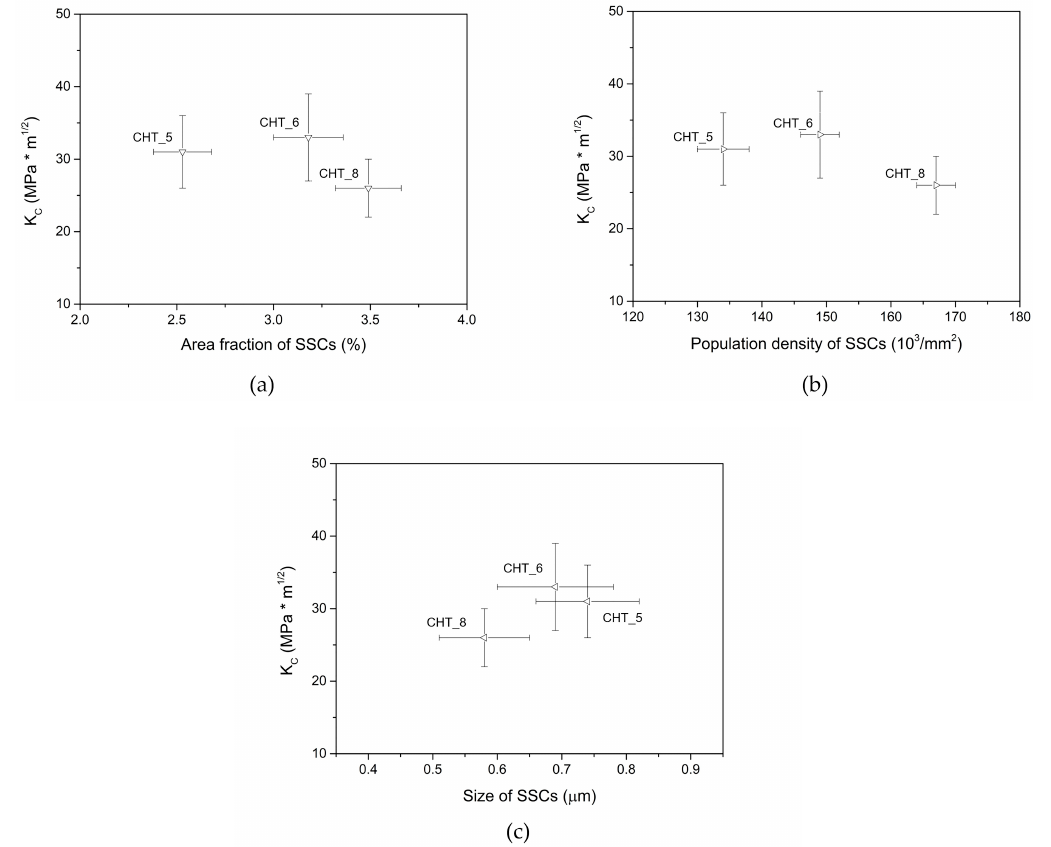
Figure 9. Relationships between plane strain fracture toughness and ( a ) area fraction, ( b ) population density and ( c ) size of small secondary carbides.